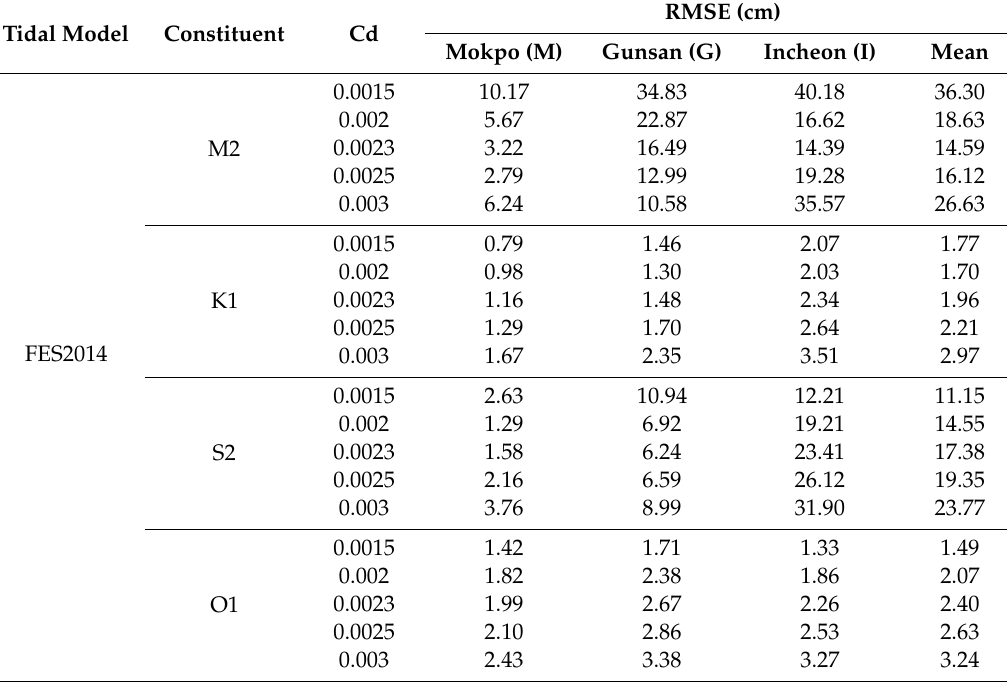
Table A2. RMSE results obtained from uniform roughness bottom for FES2014. Tidal Model